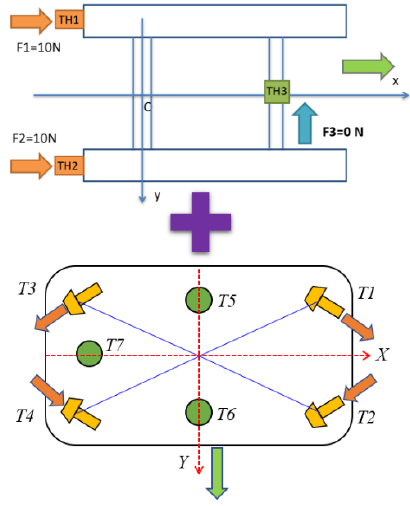
Figure 25. Thruster directions of the USV and the UUV.